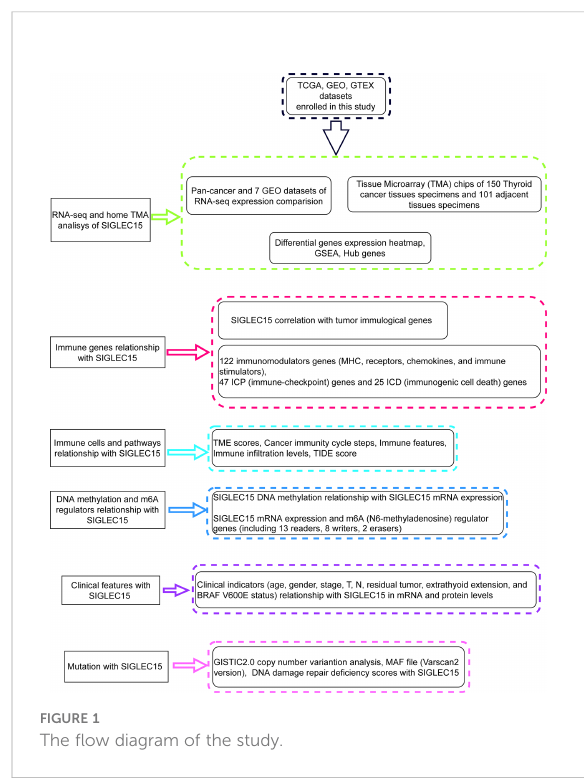
FIGURE 1 The fl ow diagram of the